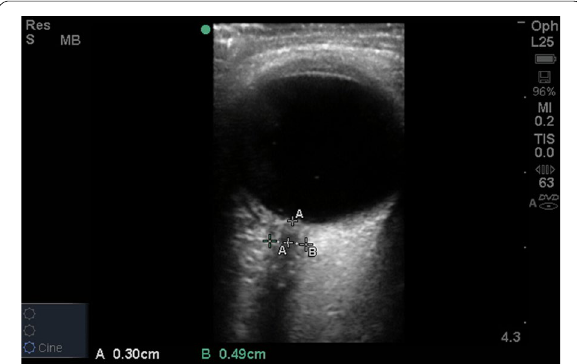
Fig. 1 Sample image of ultrasonic ONSD measurement (measure- ment “ B ”), measured 3 mm behind the optic nerve head (measure- ment “ A